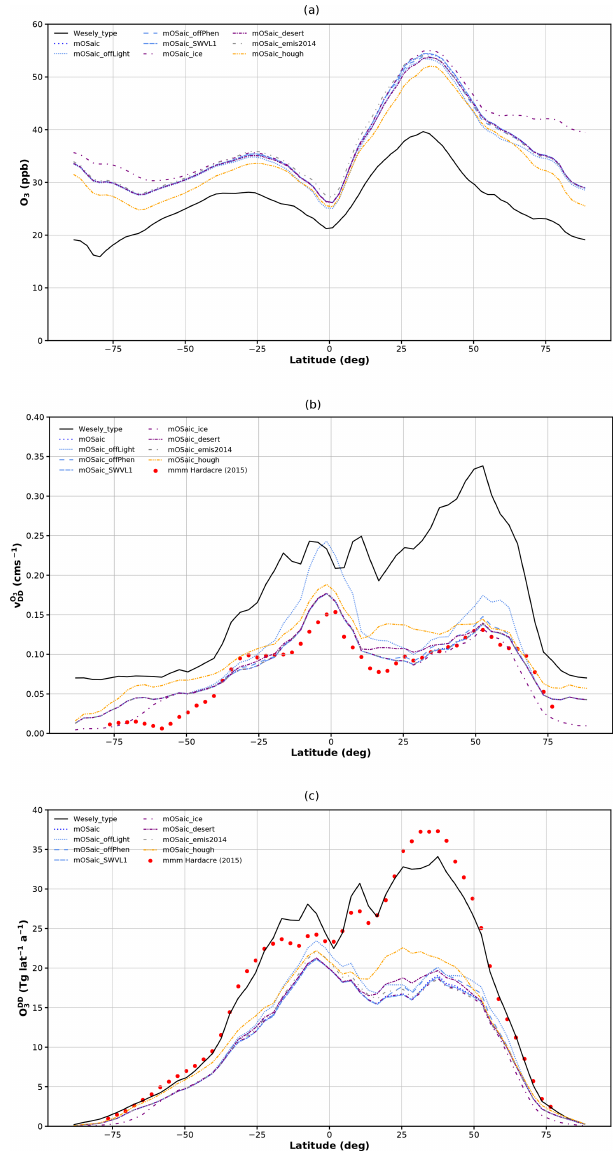
Figure 5. Comparison of the manifold Oslo CTM3 integrations with respect to (a) ozone concentrations in the lowermost model level, (b) annual average ozone dry deposition velocity, and (c) total an- nual ozone dry deposition. The different colors indicate sets of sim- ulation with similar baselines. The multi-model mean from the eval- uation of TF HTAP models by Hardacre et al. (2015) is shown as a reference (where